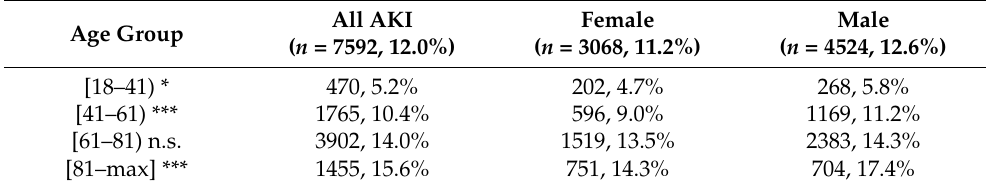
Table 3. Comparison of AKI in different age groups with regard to sex. A total of 63,239 cases were considered for the detection of AKI. n —number of cases.